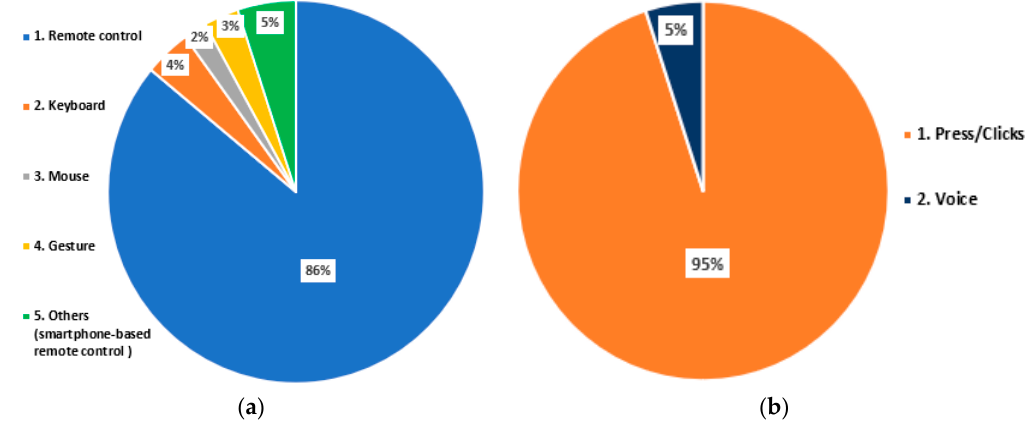
Figure 7. ( a ) Primary interaction device for smart TV; ( b ) Preferred method of